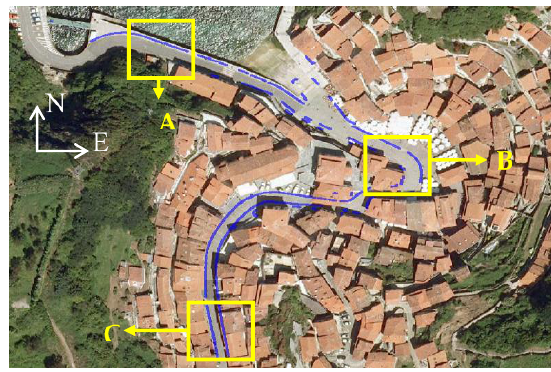
Figure 9. Aerial photograph and location of Test Site 1.